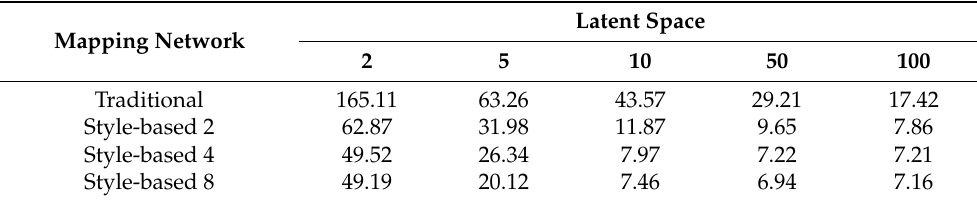
Table 4. Comparison average Fr é chet inception distance (FID) of latent space and mapping net- work size. Mapping